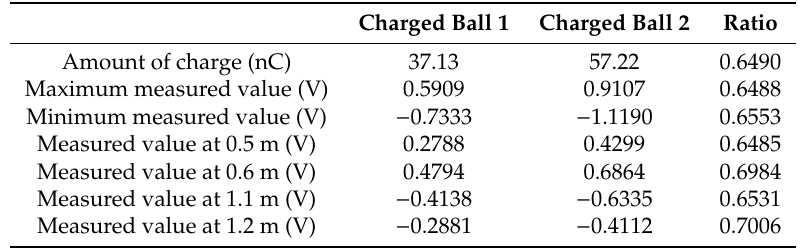
Figure 23. Results of experiment 2: ( a ) Comparison of the theoretical value with the measured voltage of charged ball 1 ; ( b ) comparison of the theoretical spectrum with the measured voltage spectrum of charged ball 1 ; ( c ) comparison of the theoretical value with the measured voltage of charged ball 2 ; and ( d ) comparison of the theoretical spectrum with the measured voltage spectrum of charged ball 2 . Table 1. Comparison of the experimental results between charged ball 1 and charged ball 2 .